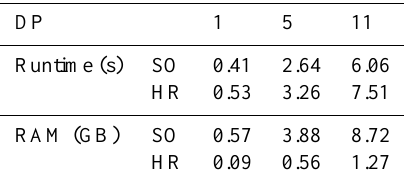
Table 2. Representative runtime (per wavelength) and RAM usage for HR and SO for similar resolutions and various numbers of dif- fuse profiles (DP).